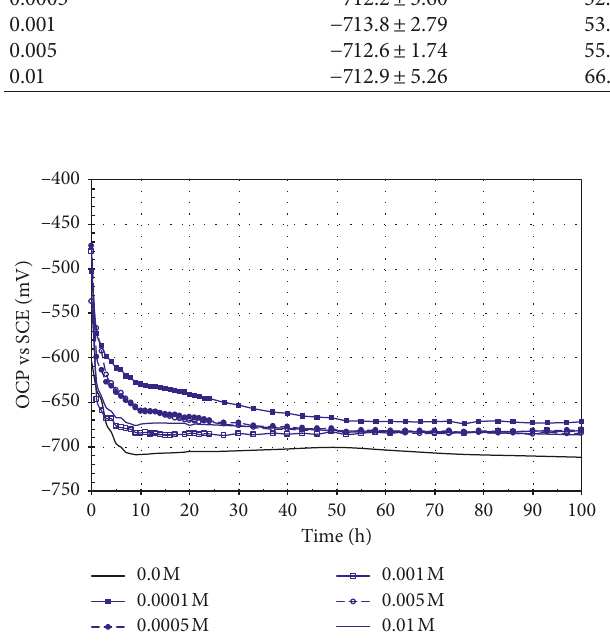
Figure 10: Evolution in polarization resistance values for API X70 steel in 3.5% NaCl solution at different concentrations of inhibitor at room